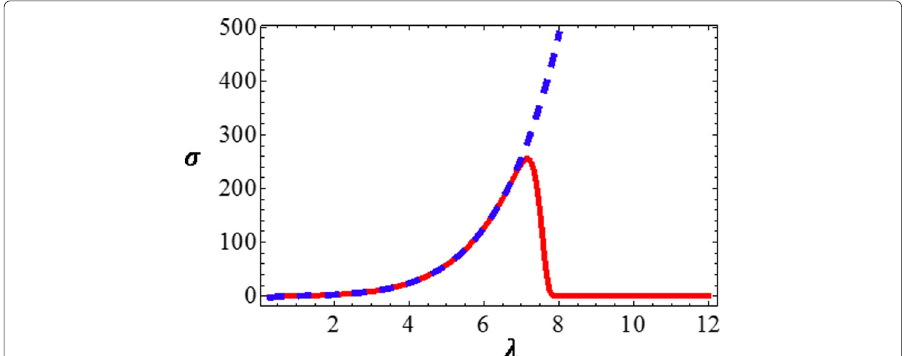
Fig. 2 Uniaxial tension of natural rubber: Cauchy stress [MPa] versus stretch. Dashedline specifies the intact model; solidline specifies the model with energy